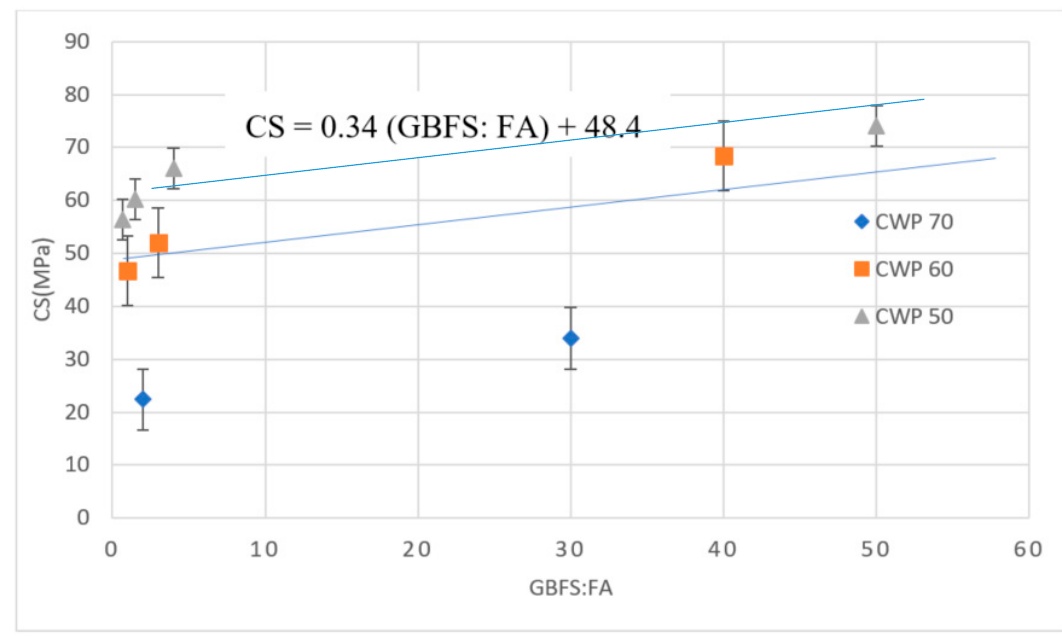
Figure 6. CS of AAM designs with a high volume of WCP.